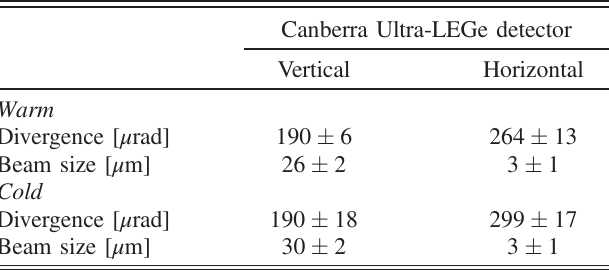
TABLE II. Electron beam parameters during the Ge-detector measurements deduced from the size of the radiation